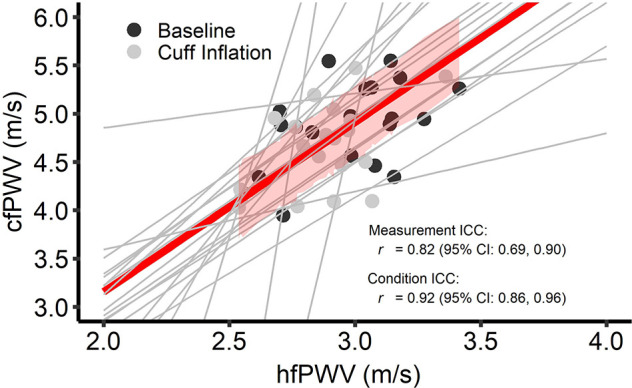
Intra-class correlations (ICC) for between-measurement (i.e., overall comparison between criterion and test measure) and between-condition [i.e., change (cuff – base) in the test measure vs. change in the criterion measure] carotid-femoral pulse wave velocity (cfPWV) and heart-femoral pulse wave velocity (hfPWV) comparisons. n = 20. Red line and red shading depict overall between-measurement agreement and standard error, respectively. Gray lines depict between-condition agreement.